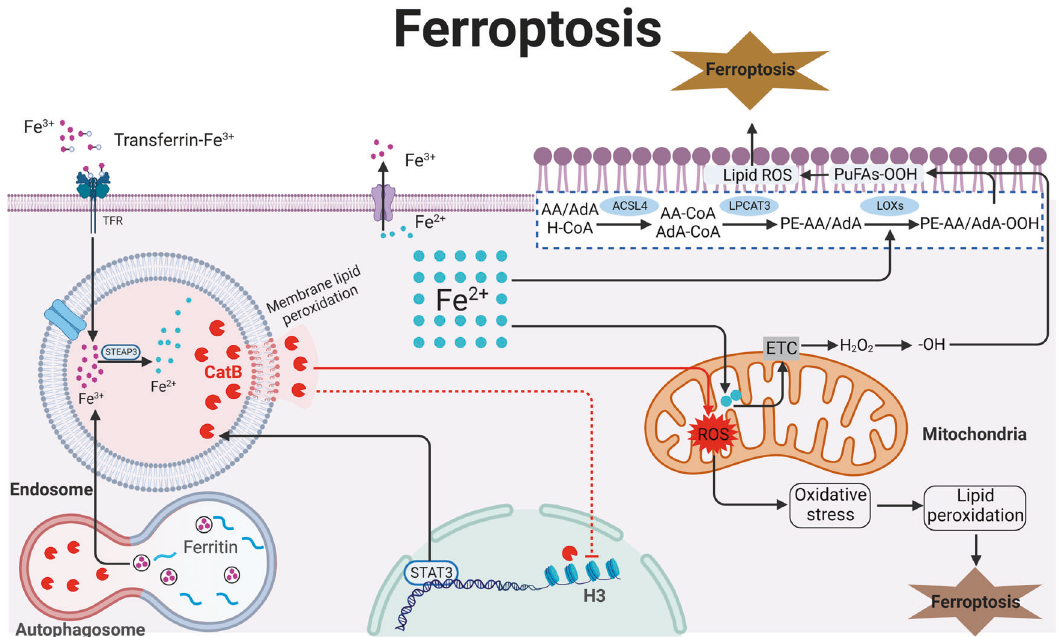
Fig. 4 Schematic representation of CatB and its substrates in the core ferroptosis machinery. Ferroptosis is mainly caused by iron- dependent lipid peroxidation. Free Fe 3 + forms a complex with extracellular transferrin, which binds to a TfR1 on the cell membrane and forms endosomes that are transported in the cell under endocytosis. In the cell, Fe 3 + is catalyzed into Fe 2 + by the enzyme STEAP3. Fe 2 + can be pumped out through ferroportin which is located on the cell membrane. Excess Fe 2 + generates ROS through Fenton chemical reaction, leading to the continuous accumulation of lipid ROS within the cell and the eventual development of ferroptosis. ROS can also interact with PUFAs on the lipid membrane to form lipid ROS. When a large amount of lipid ROS accumulates in the cell, it causes ferroptosis. Membrane lipid peroxidation of lysosome increases the permeability of the lysosomal CatB, which is capable to promote mitochondrial ROS production and degrades H3 in the nucleus. ACSL4 acyl-coenzyme A synthetase long chain family member 4, CatB cathepsin B, DMT1 divalent metal ion transporter 1, ETC electron transport chain, H3 histone 3, LOX lysyl oxidase, LPCAT3 lysophosphatidylcholine acyltransferase 3, PUFAs polyunsaturated fatty acids, ROS reactive oxygen species, STEAP3 six-transmembrane epithelial antigen of the prostate, TfR1 transferrin receptor